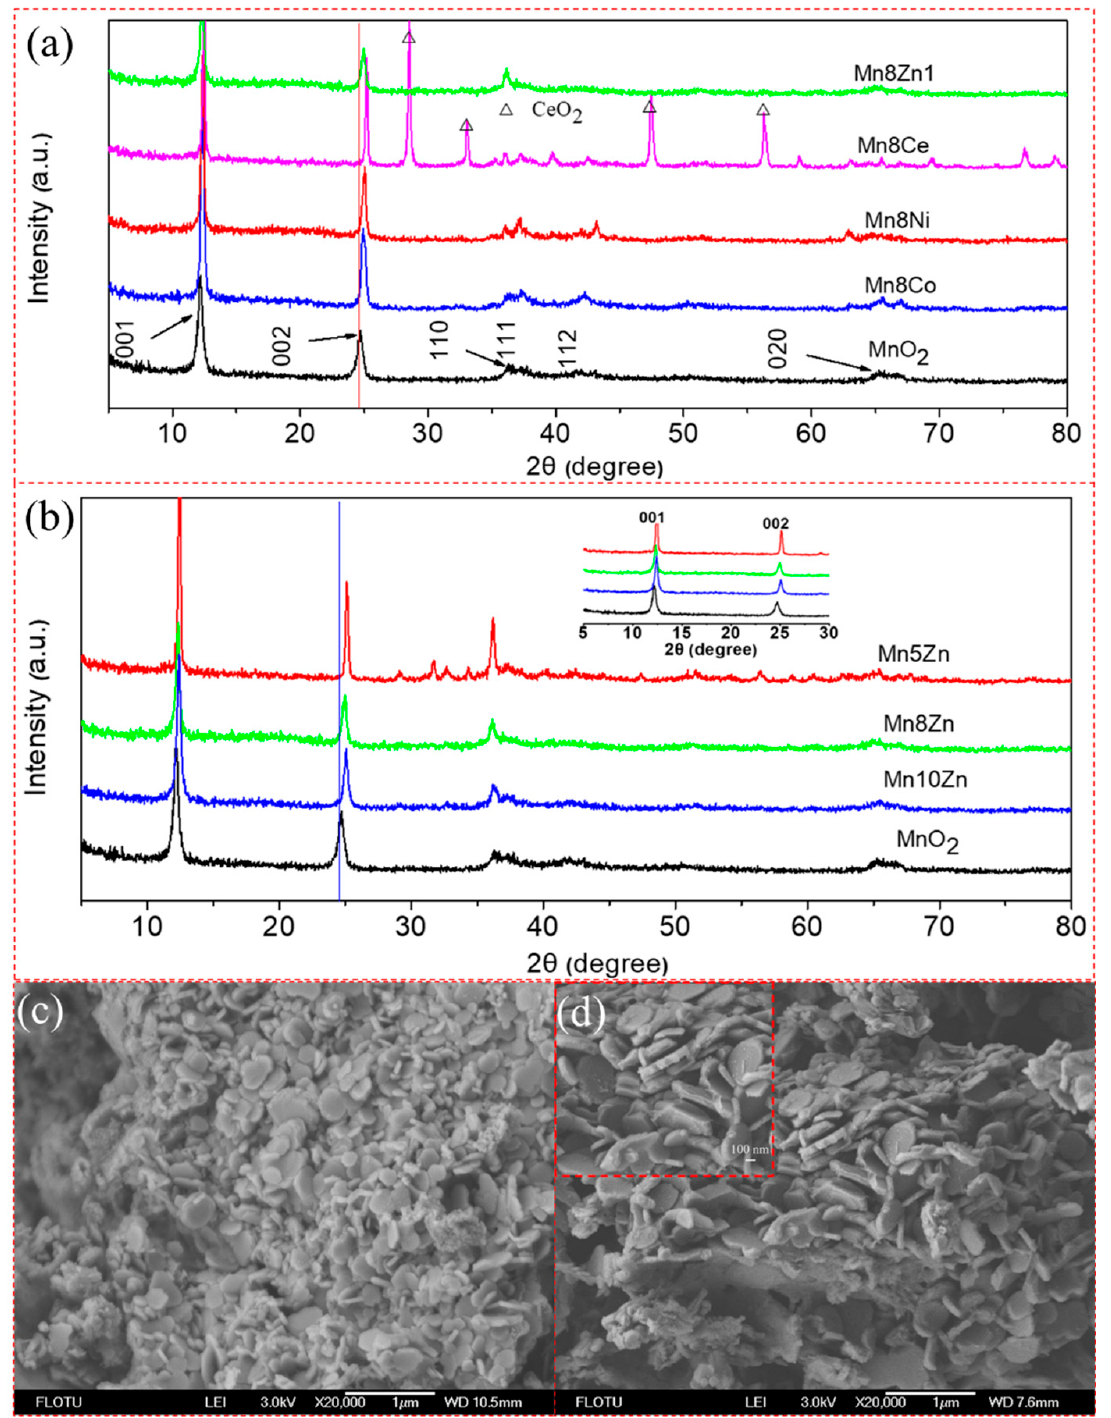
Figure 2. ( a , b ) XRD patterns of the layered MO x - δ -MnO 2 (M = Co, Ni, Zn, Ce) materials; ( c , d ) SEM images of the Mn5Zn and Mn10Zn samples, respectively. Inserted image of ( b ) is the local enlarged XRD patterns ranges from 2 θ = 5 to 30 degree.